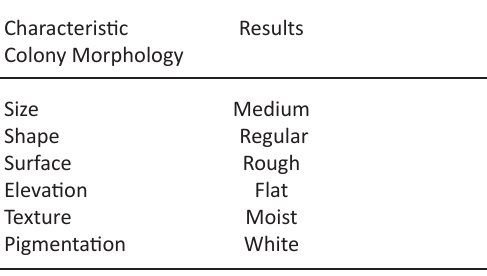
Table 1. Morphological characteristics of isolate TWSS-P-2 on a nutrient agar plate